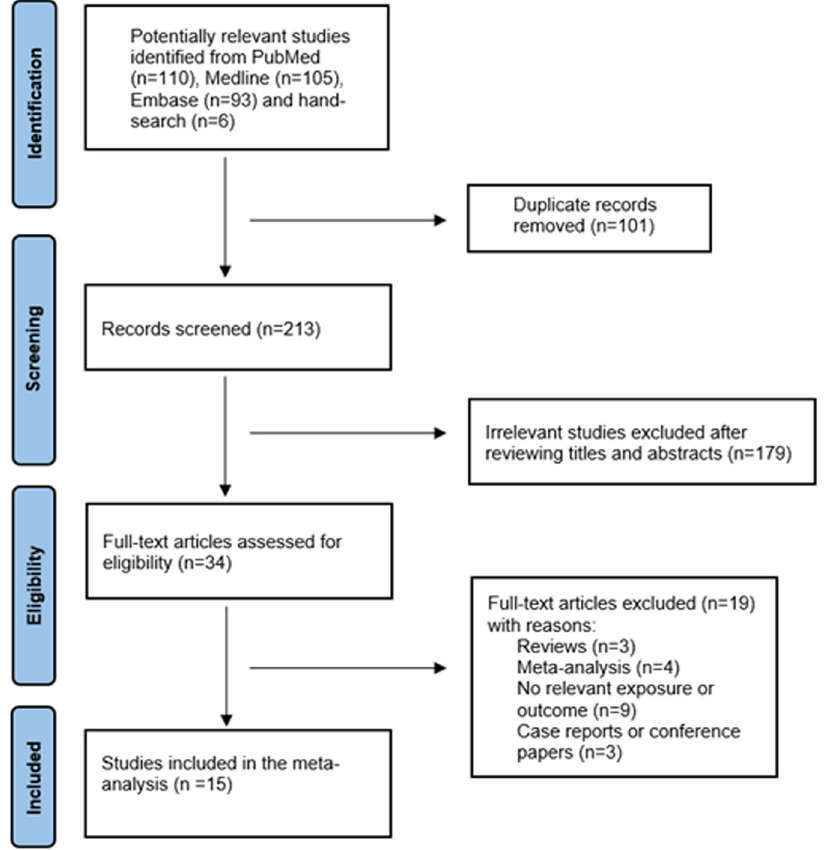
Fig. 1 Flow diagram showing the selection process of articles. 15 studies were included in the